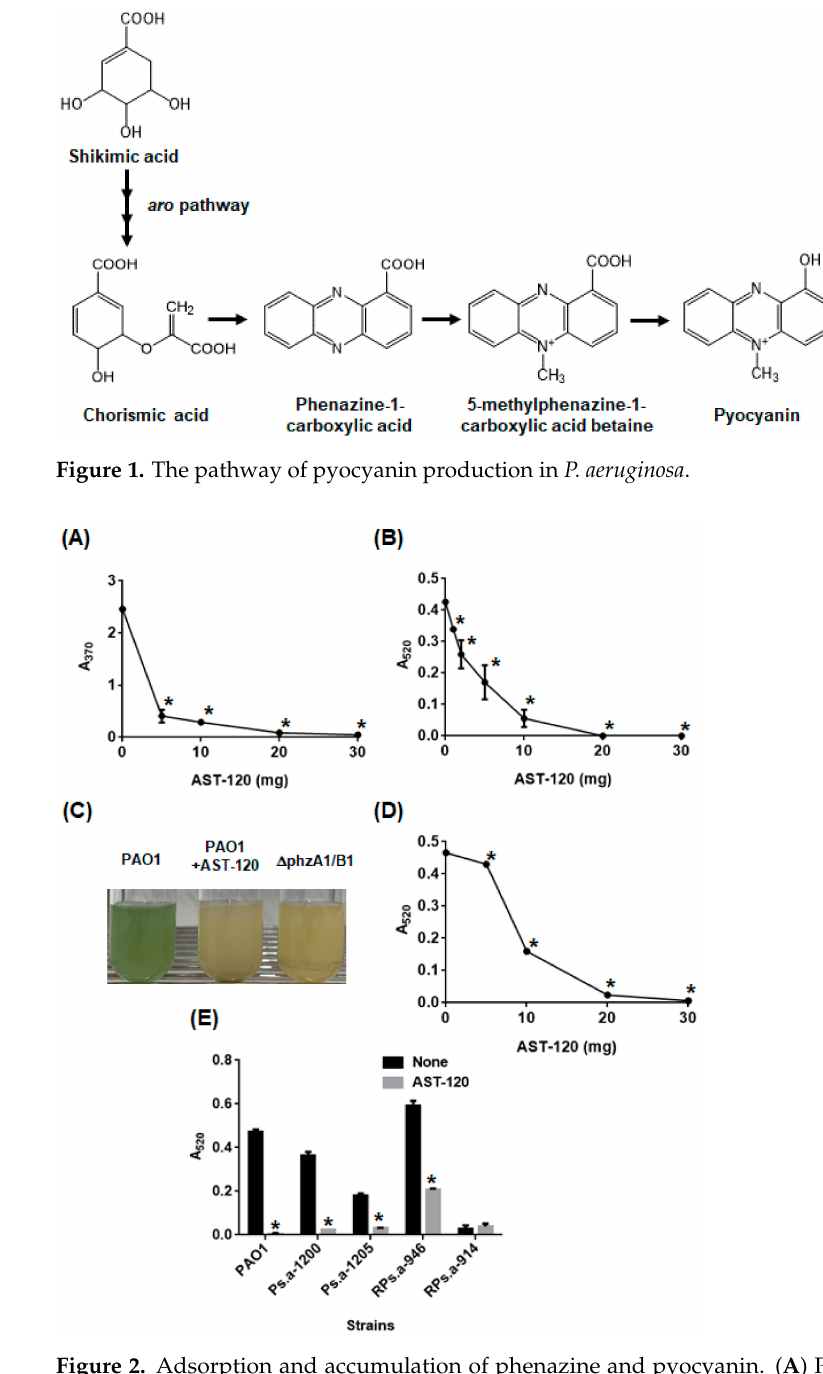
Figure 2. Adsorption and accumulation of phenazine and pyocyanin. ( A ) Phenazine level corre- sponding to the absorbance of 370 nm in supernatant from an aqueous solution containing 200 µ M synthetic phenazine after incubation for 2 h with or without AST-120. ( B ) Pyocyanin level corre- sponding to the absorbance of 520 nm in supernatant from PAO1 culture after incubation for 2 h with or without AST-120. ( C ) Pyocyanin accumulation in cultures of PAO1 grown with and without 30 mg AST-120 and phzA1/B1 mutant (designated ∆ phzA1/B1). ( D ) Pyocyanin level corresponding to the absorbance of 520 nm in PAO1 culture grown with or without AST-120. ( E ) Pyocyanin level corresponding to the absorbance of 520 nm in PAO1 and P. aeruginosa clinical isolates that are resistant to some antimicrobial culture grown with and without 30 mg AST-120. Data plotted are the means from three independent experiments; error bars indicate the standard deviations. Asterisks denote significance for values ( p < 0.05) of samples or bacterial cultures in the presence of AST-120 relative to those in the absence of